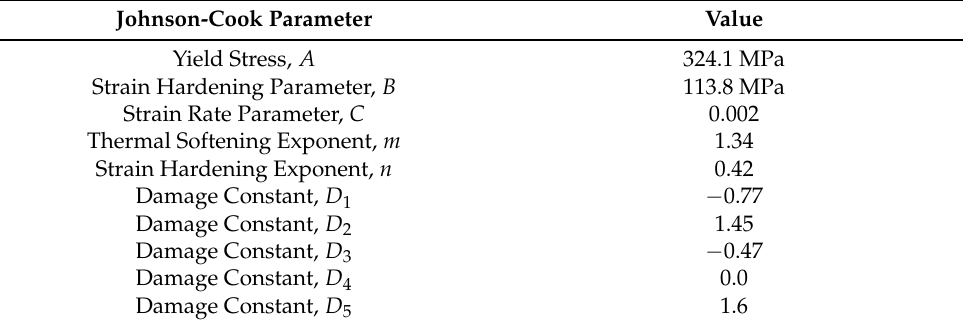
Table 2. Johnson-Cook Model Parameters for 6061-T6 Aluminum [76].